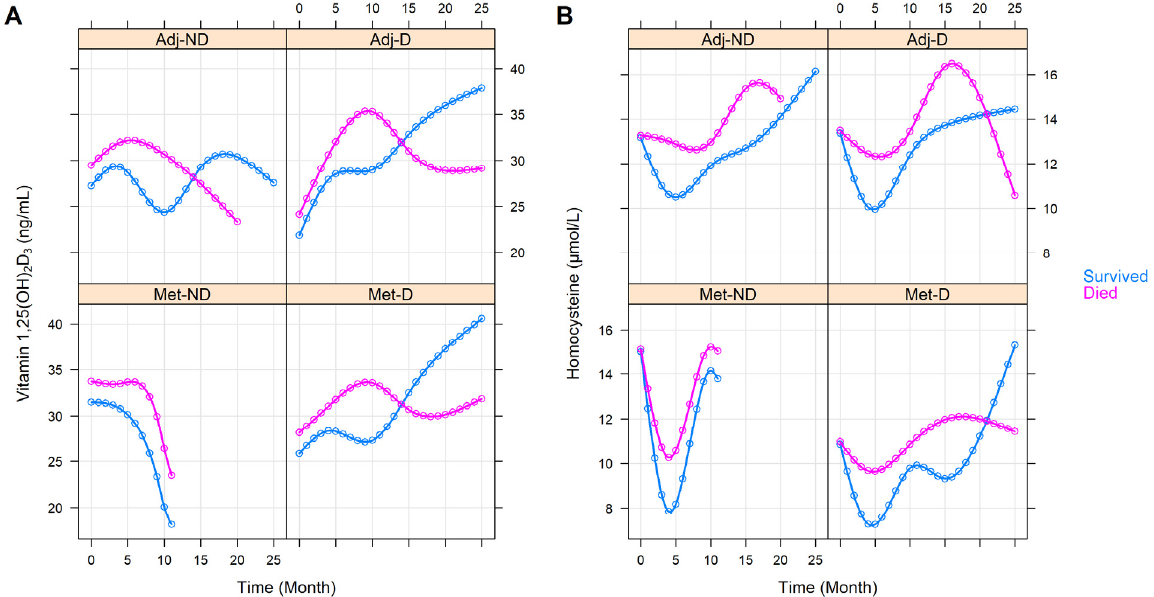
Figure 5. Predictions of average longitudinal changes in vitamin 1,25(OH) 2 D 3 ( A ) and homocysteine ( B ) level of the study groups throughout the first 25 months of the observation time, stratified by death. Adj-ND: patients without metastasis and no vitamin D 3 supplementation; Adj-D: patients without metastasis with vitamin D 3 supplementation; Met-ND: patients with metastasis and no vitamin D 3 supplementation; Met-D: patients with metastasis with vitamin D 3 supplementation.